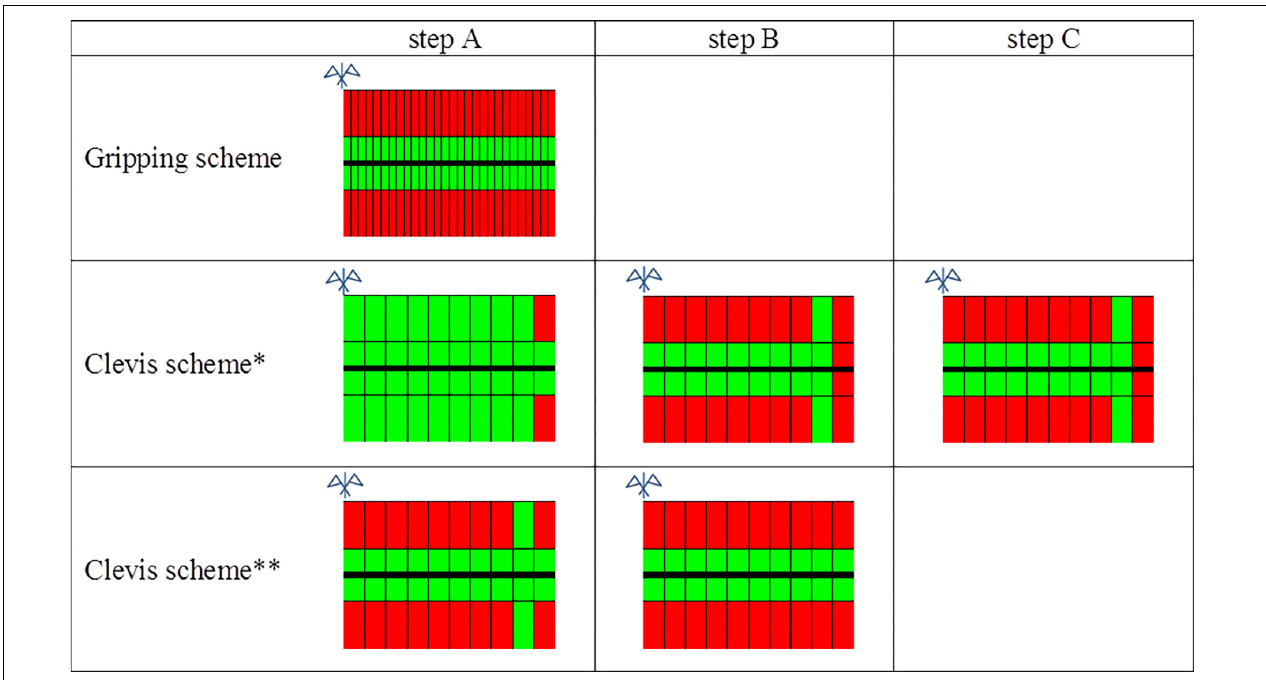
FIGURE 8 | Damage status of the components of the model (one half specimen): undamaged (green); damaged (red), ∗ model with the additional end elements, ∗∗ model without additional end